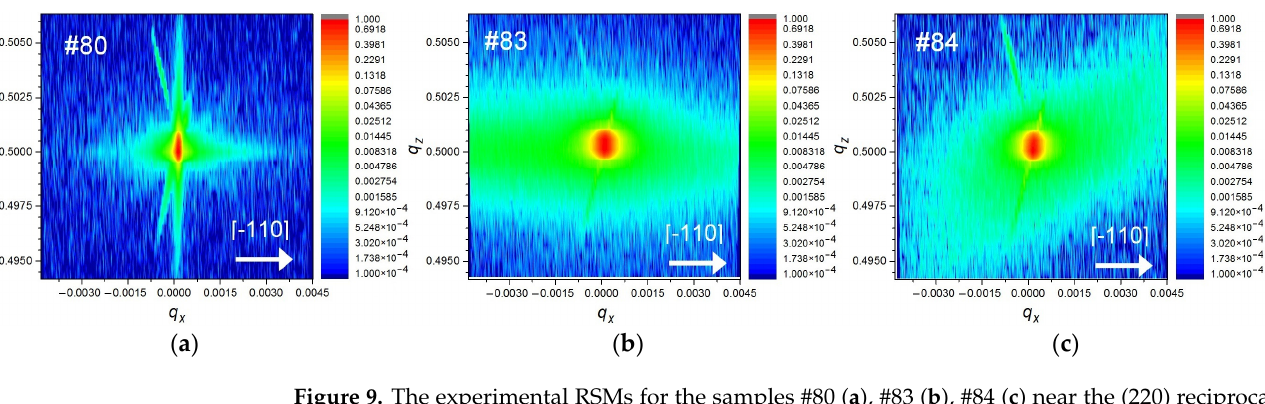
(cid:2) (cid:3) 110 (according to the direction of the